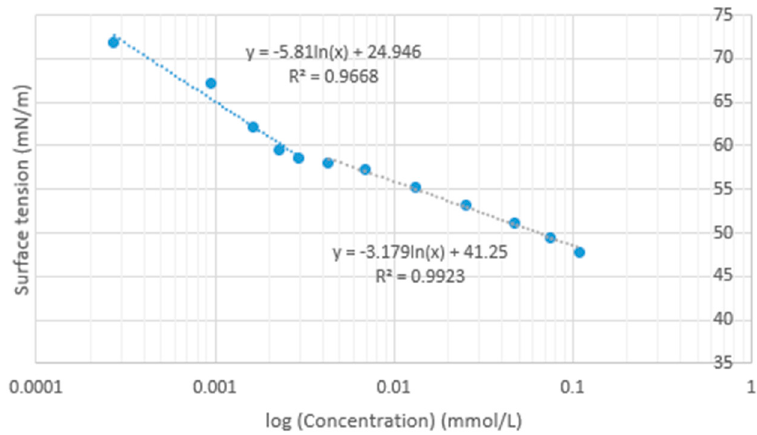
Figure 3. Evolution of the surface tension of a solution of surfactant in water.